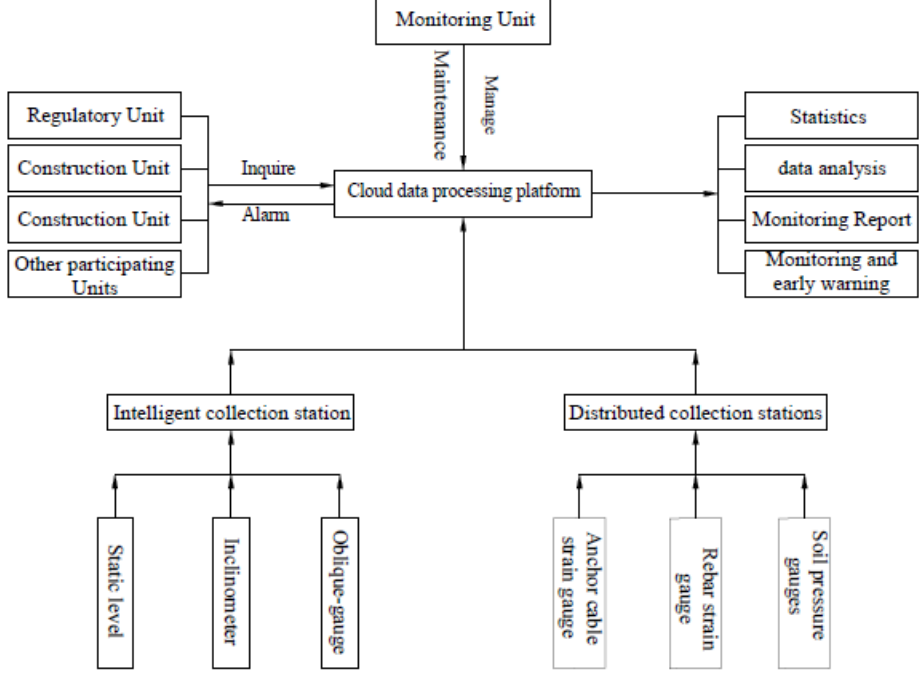
Figure 10. Function structure diagram of the automatic monitoring system.